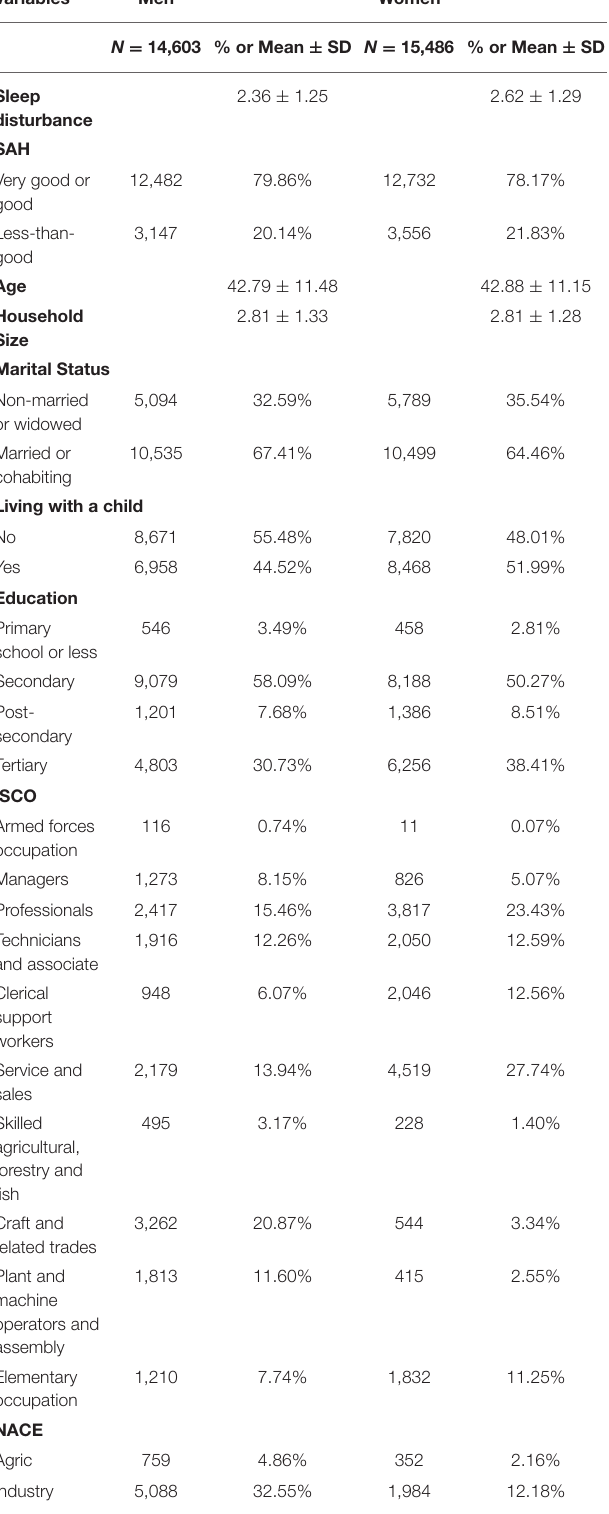
TABLE 1 | General characteristics of participants of the European Working Condition Survey 2015.